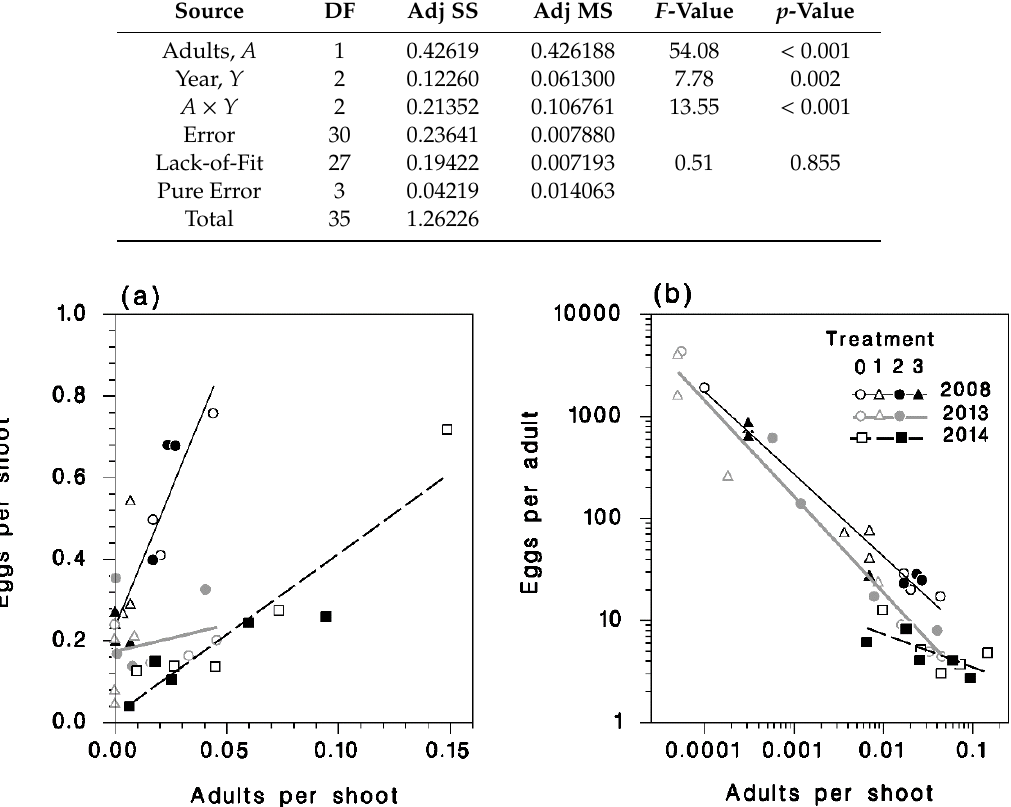
Figure 5. Relationship between adult density, and ( a ) egg density (lines: Equation (3)) and ( b ) apparent fecundity (eggs / adult) (lines: Equation (4)). Treatments: 0 is untreated, 1 is Btk or tebuzenozide, 2 is pheromone, 3 is Btk and pheromone. Table 4. General linear model (Equation (4)) of the effects of emerging adult density ( A ), Year ( Y ) and pheromone treatment ( T ) on apparent fecundity, the ratio of eggs to adults ( E / A ). Reduced model.